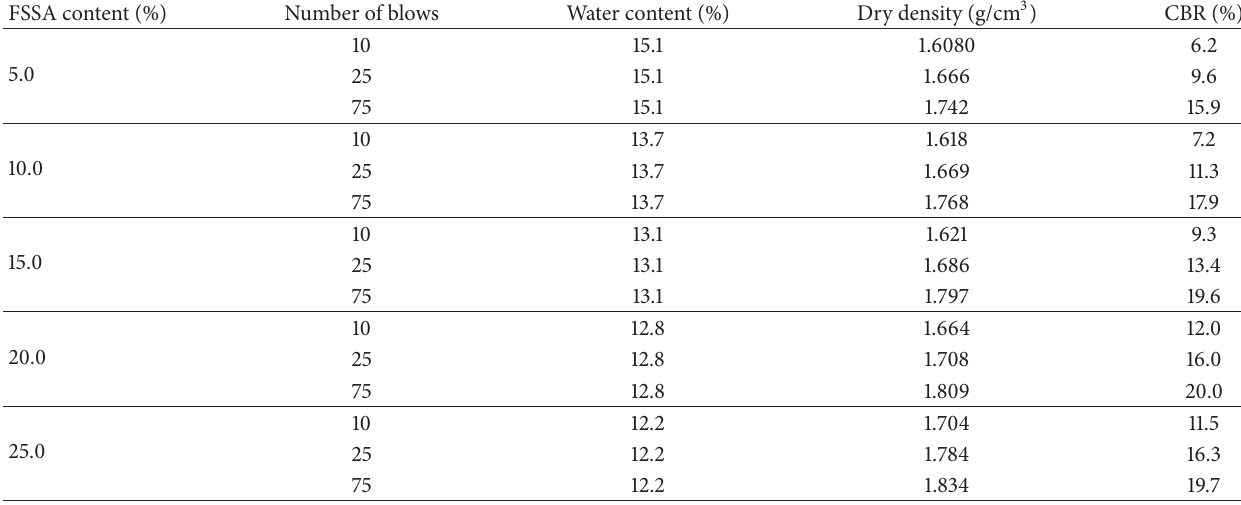
Table 8: CBR values of the three compaction efforts samples of soil with FSSA additives.